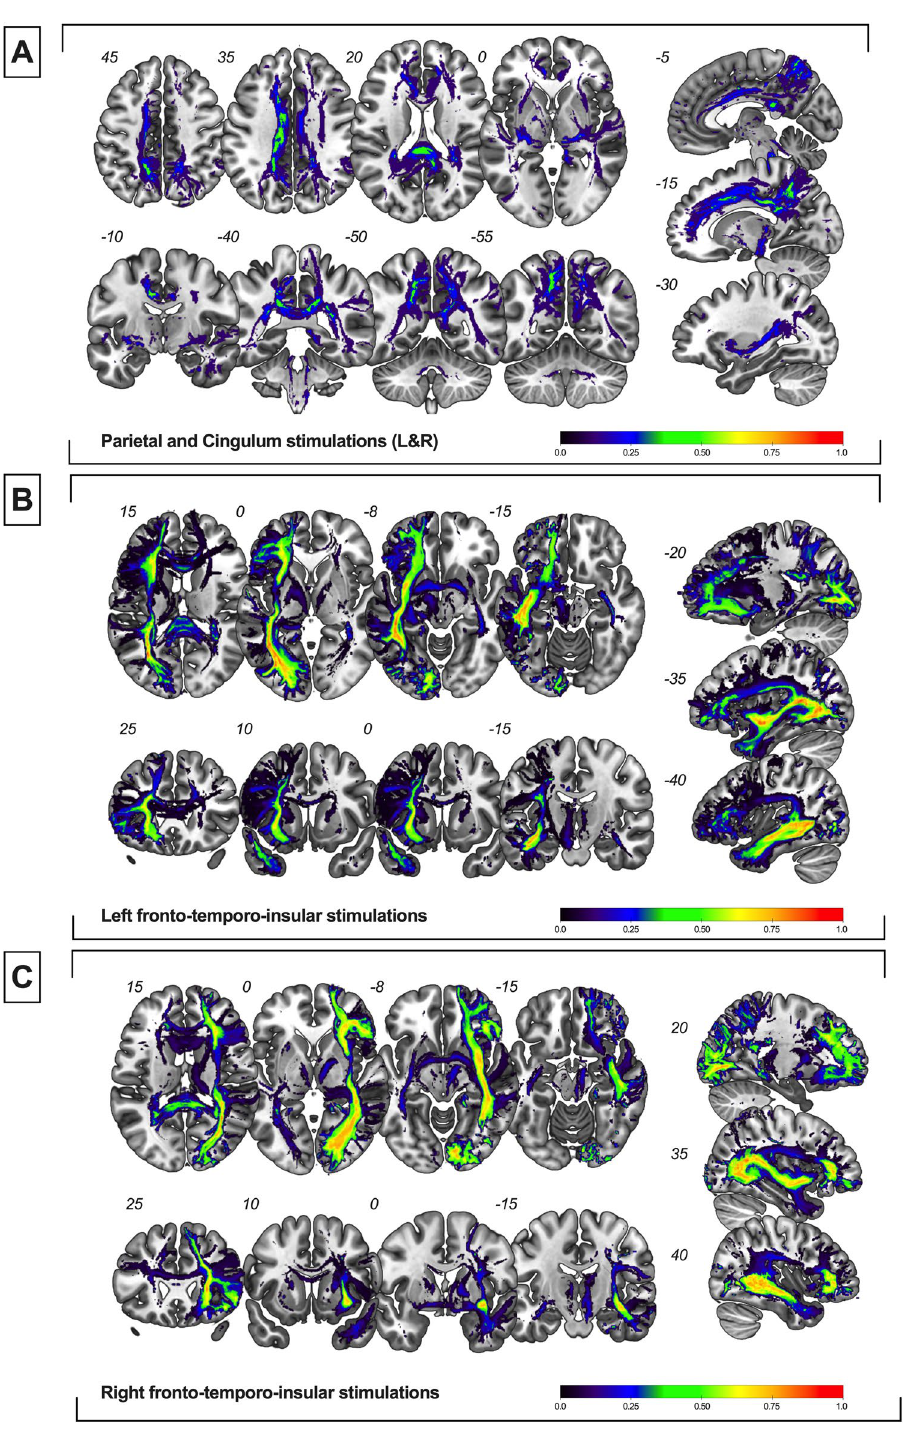
Figure 3. Average disconnectome maps for disruptions of self-evaluative processing. (A ) Average disconnectome maps generated with bilateral posteromedial sites (n = 8). ( B ) Average disconnectome maps generated with left fronto-temporo-insular sites (n = 41). ( C ) Average disconnectome maps generated with right fronto-temporo-insular sites (n =